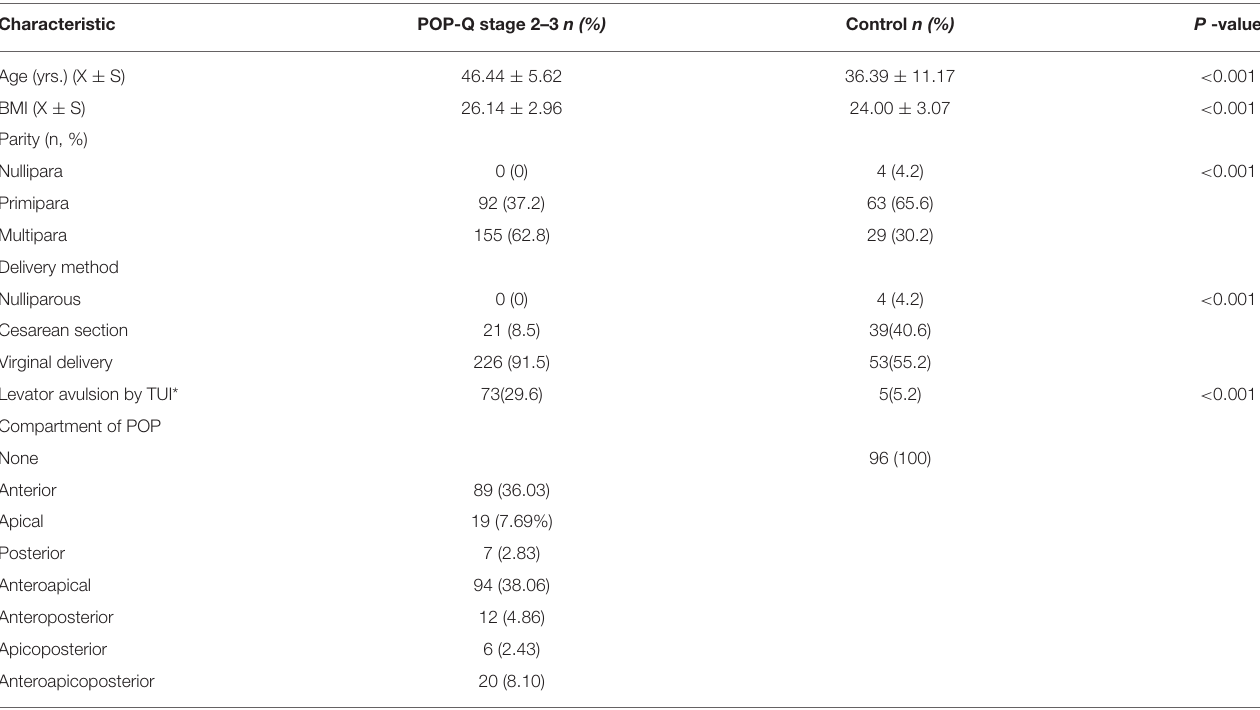
TABLE 1 | Demographic and reproductive history characteristics of 343 women visiting a urogynecology clinic according to the diagnosis of significantly objective prolapse (International Continence Society POP quantification, stage 2–3).